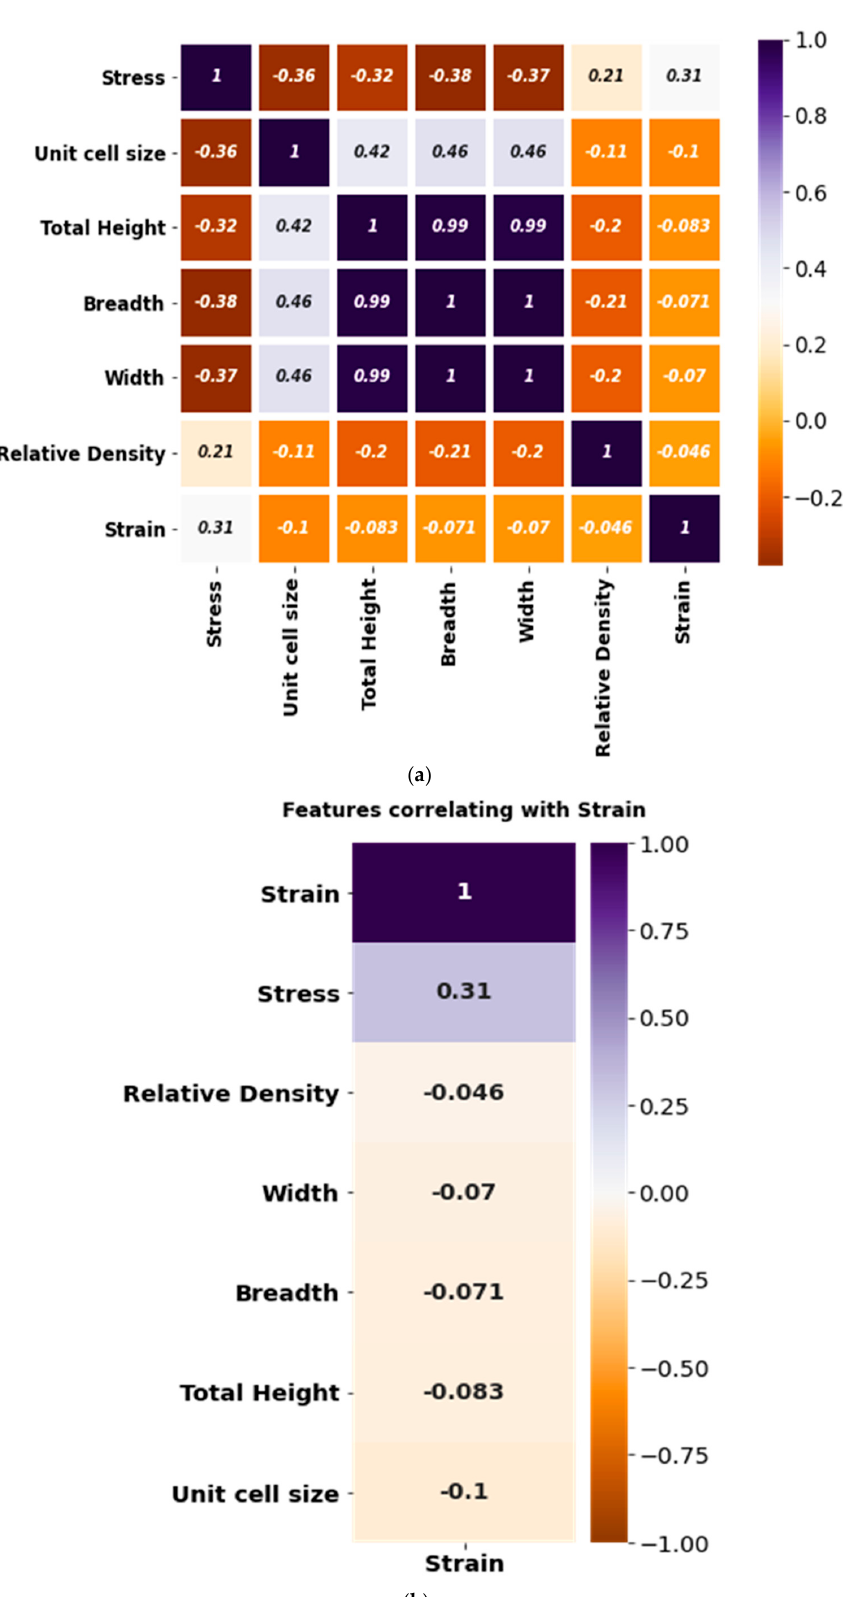
Figure 5. Features correlation with strain ( a ) with inputs and outputs and ( b ) with outputs.